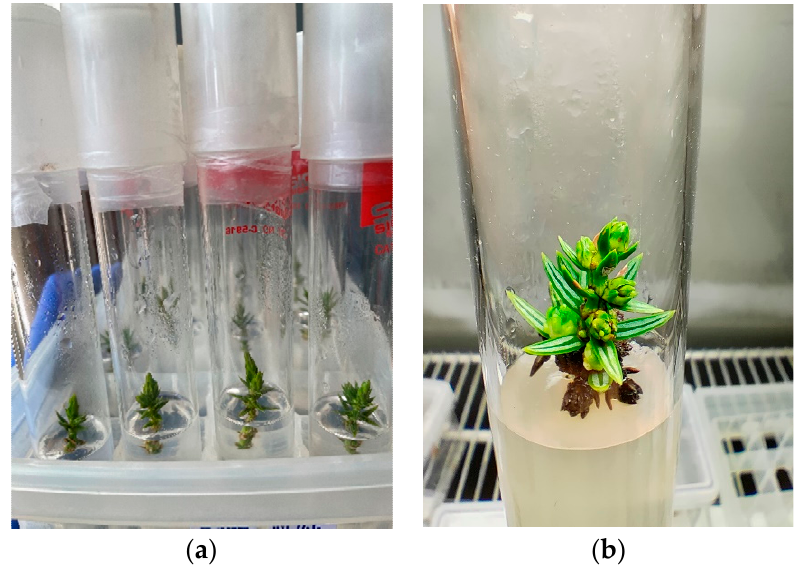
Figure 4. Culture establishment and shoot formation: ( a ) explants of Juniperus drupacea on MS medium containing 4 μΜ BA after 10 days of culture; ( b ) shoot formation on DKW medium containing 4 μΜ BA after 4 weeks of culture. Explant discoloration (browning) and necrotic zones of the explants are common among Juniperus species. Test tube diameter = 25 mm.